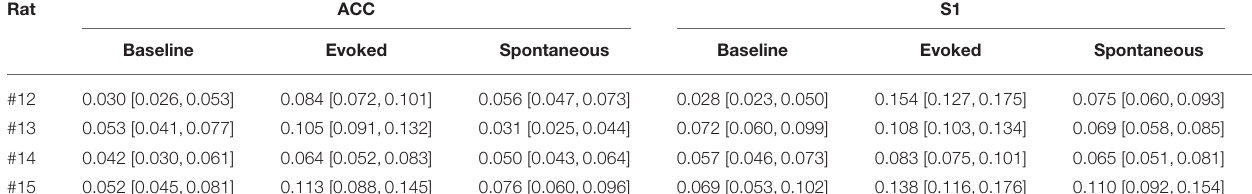
TABLE 2 | Results of phase-amplitude coupling for the r -statistic (95% confidence intervals shown in bracket, and the greatest values in each region are shown in bold font).